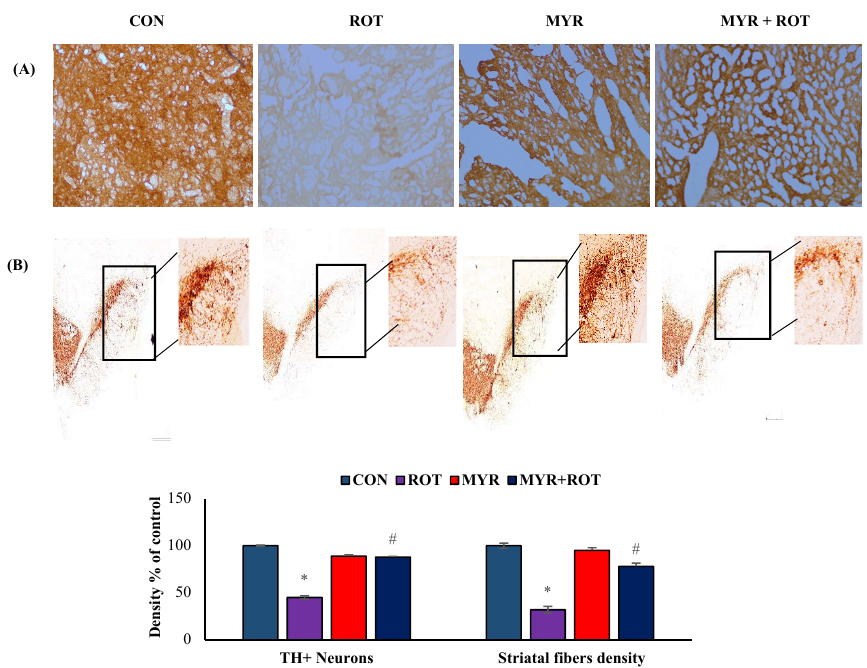
Figure 3. The effect of myrcene on the expression of TH-ir dopamine nerve fibers in the striatum ( A ) and number of dopaminergic (DA) neurons in the substantia nigra compacta (SN) ( B ). Scale bar: 100 µm. The values are expressed as percent mean ± SEM ( n = 3). * p < 0.05 (ROT vs. CON), # p < 0.05 (MYR vs. ROT). 2.4. Myrcene Reduced the ROT-Induced Activation of Microglia and Astroglia Figure 4 reveals Iba-1 and GFAP, a marker of reactive microglia and astrocytes, re- spectively, using immunofluorescent labeling in the striatum. The quantitative analysis of activated microglia and astrocytes is shown as a percentage of the control (Figure 4). ROT injections trigger microglial activation (F 3, 24 = 7.422 p < 0.000) and appear with large cell bodies and lesser processes along with activated astrocytes, as demonstrated by the in- creased expression (F 3,19 = 9.11 p < 0.000) of GFAP-positive cells. Interestingly, myrcene treatment substantially reduced Iba-1 and GFAP expression in the striatum, compared with that in ROT-injected rats.